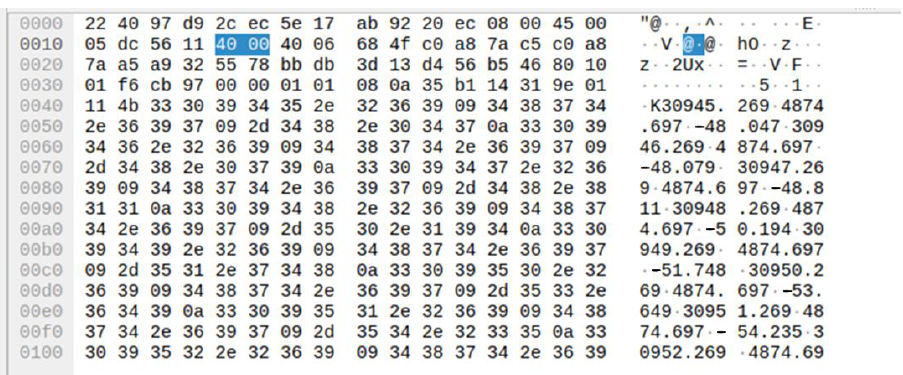
Figure 10. Non-encrypted data package capture.